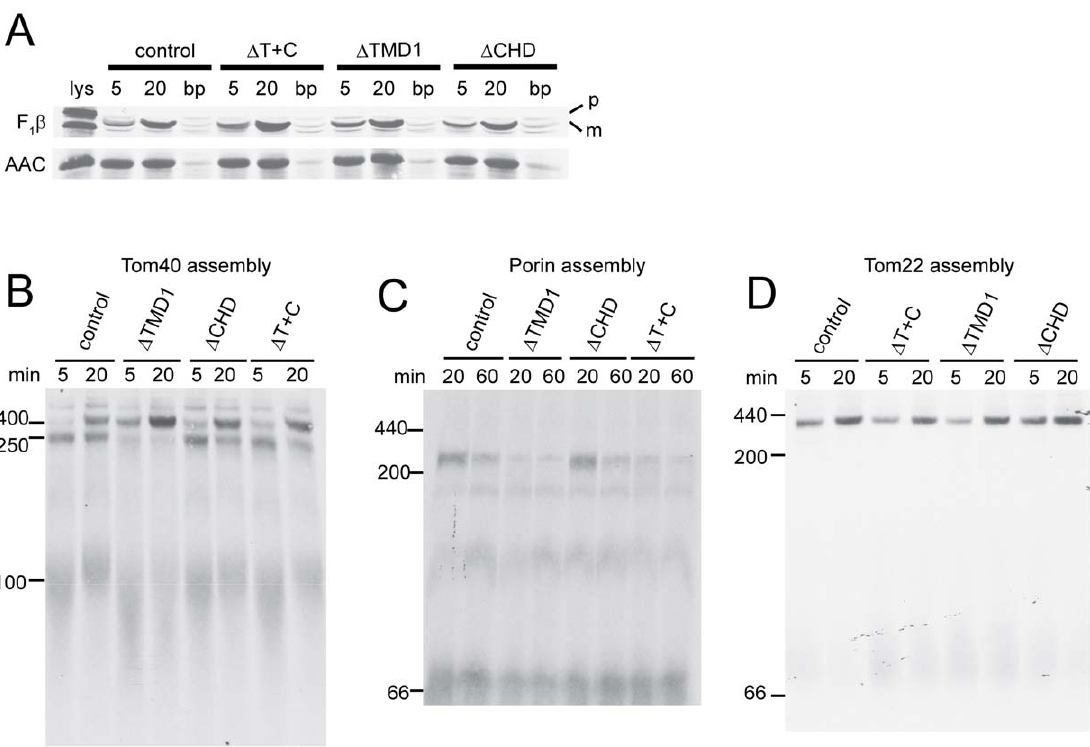
Figure 7. Role of Tob37 predicted TMDs on the import of mitochondrial precursor proteins into mitochondria. Import and assembly were analyzed as described in the legend to Figure 2 for the indicated precursors. (a) Import of F 1 b and AAC. (b) Assembly of Tom40. (c) Assembly of porin. (d) Assembly of Tom22.